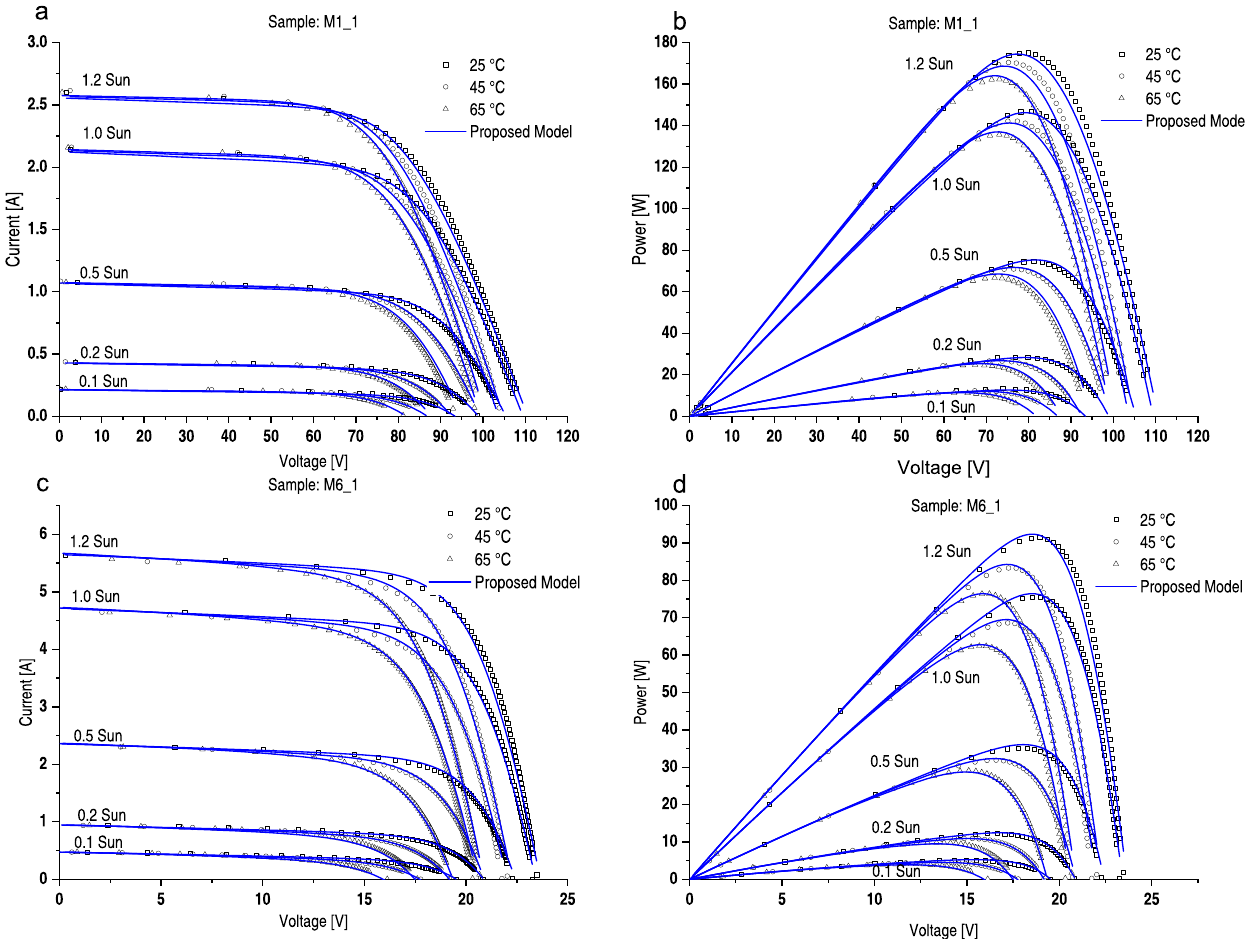
Fig. 6 Simulated and measured IV and P – V curves for module samples M1_1 and M6_1. The markers represent the measured IV points, and the blue lines represent the IV curves estimated by the developed